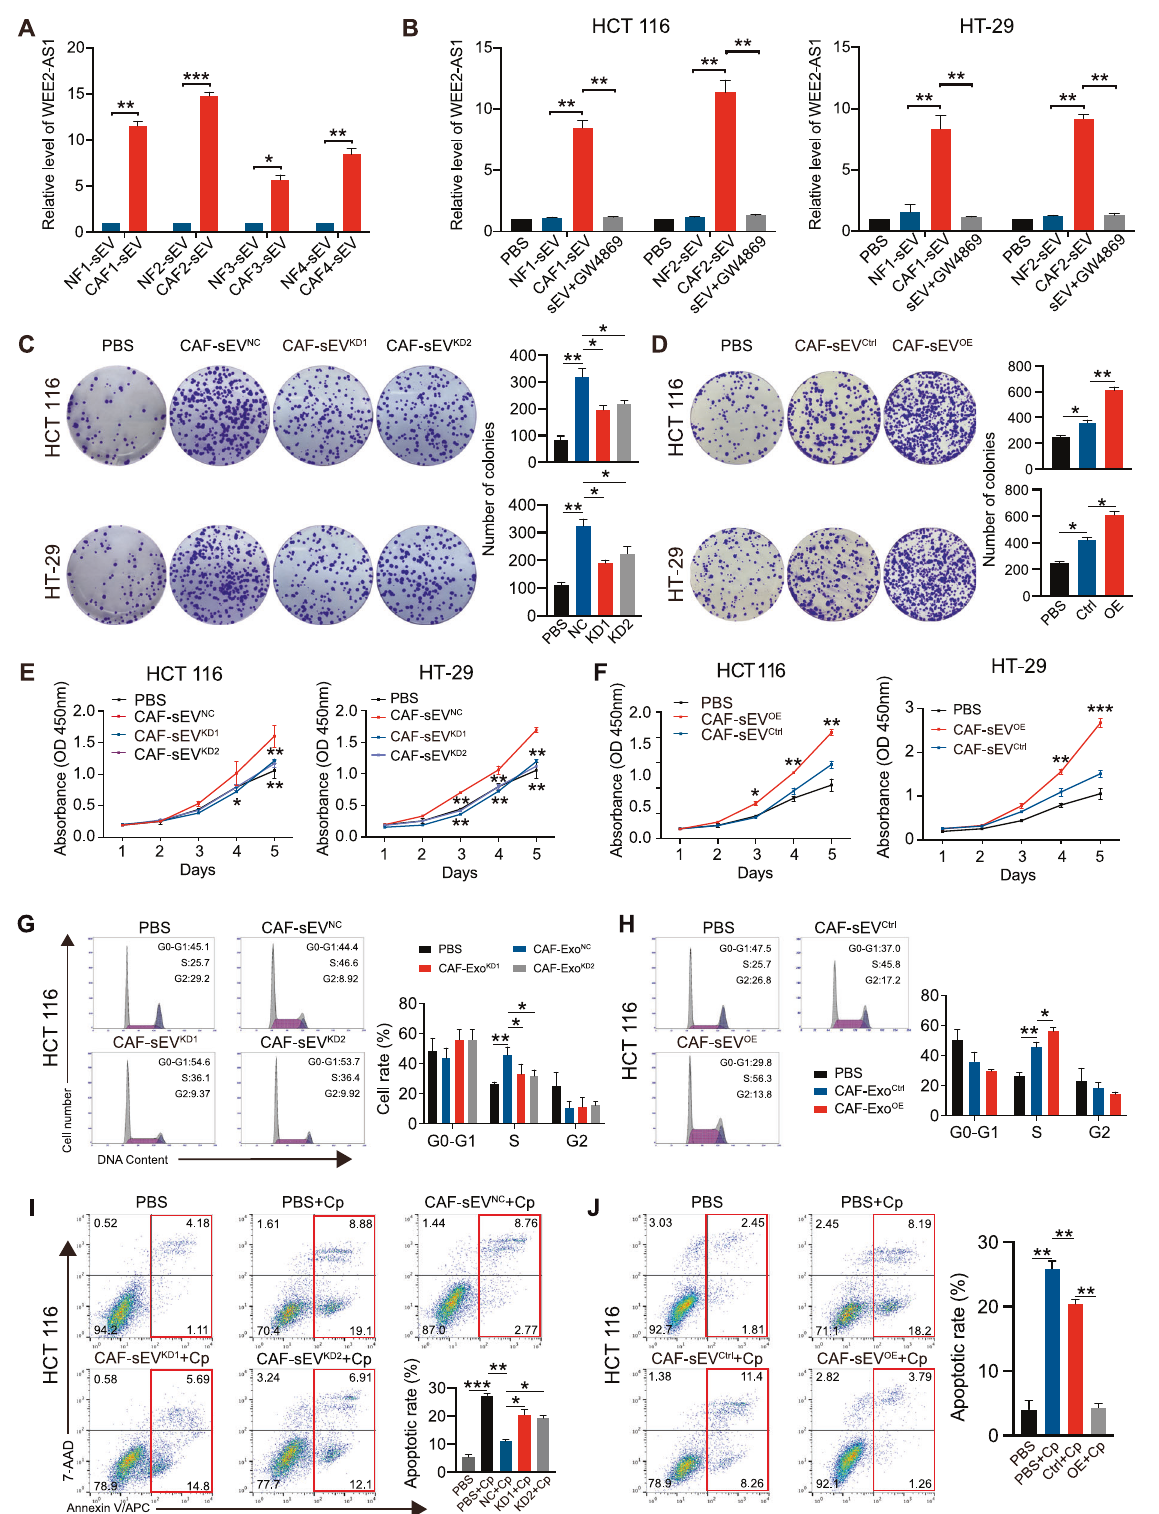
Fig. 3 Effect of sEVs WEE2-AS1 on CRC cellular phenotype. A Level of WEE2-AS1 in four paired NF-sEVs and CAF-sEVs, as determined by qRT- PCR. B Level of WEE2-AS1 in HCT 116 and HT-29 cells are co-cultures with PBS, NF-sEVs, CAF-sEVs, and CAF-sEVs + GW4869, as determined by qRT-PCR. C , D Assessment of the viability of HCT 116 and HT-29 cells co-cultured with sEVs by colony formation assays. E , F CCK8 assays are used to determine the proliferation of CRC cells co-cultured with sEVs. G , H Flow cytometry showing signi fi cant decreases or increases in the proportion of cells in S or G1-phase, respectively, when HCT 116 cells co-cultured with CAF-sEVs KD or CAF-sEVs OE . I , J Cells were treated with cisplatin (5ug/ml for 24 h). Flow cytometry is used to detect the apoptotic rates (LR + UR) of cells. LR, early apoptotic cells; UR, terminal apoptotic cells. Data are shown as mean ± SD of three independent experiments, * P < 0.05, ** P < 0.01, *** P < 0.001.